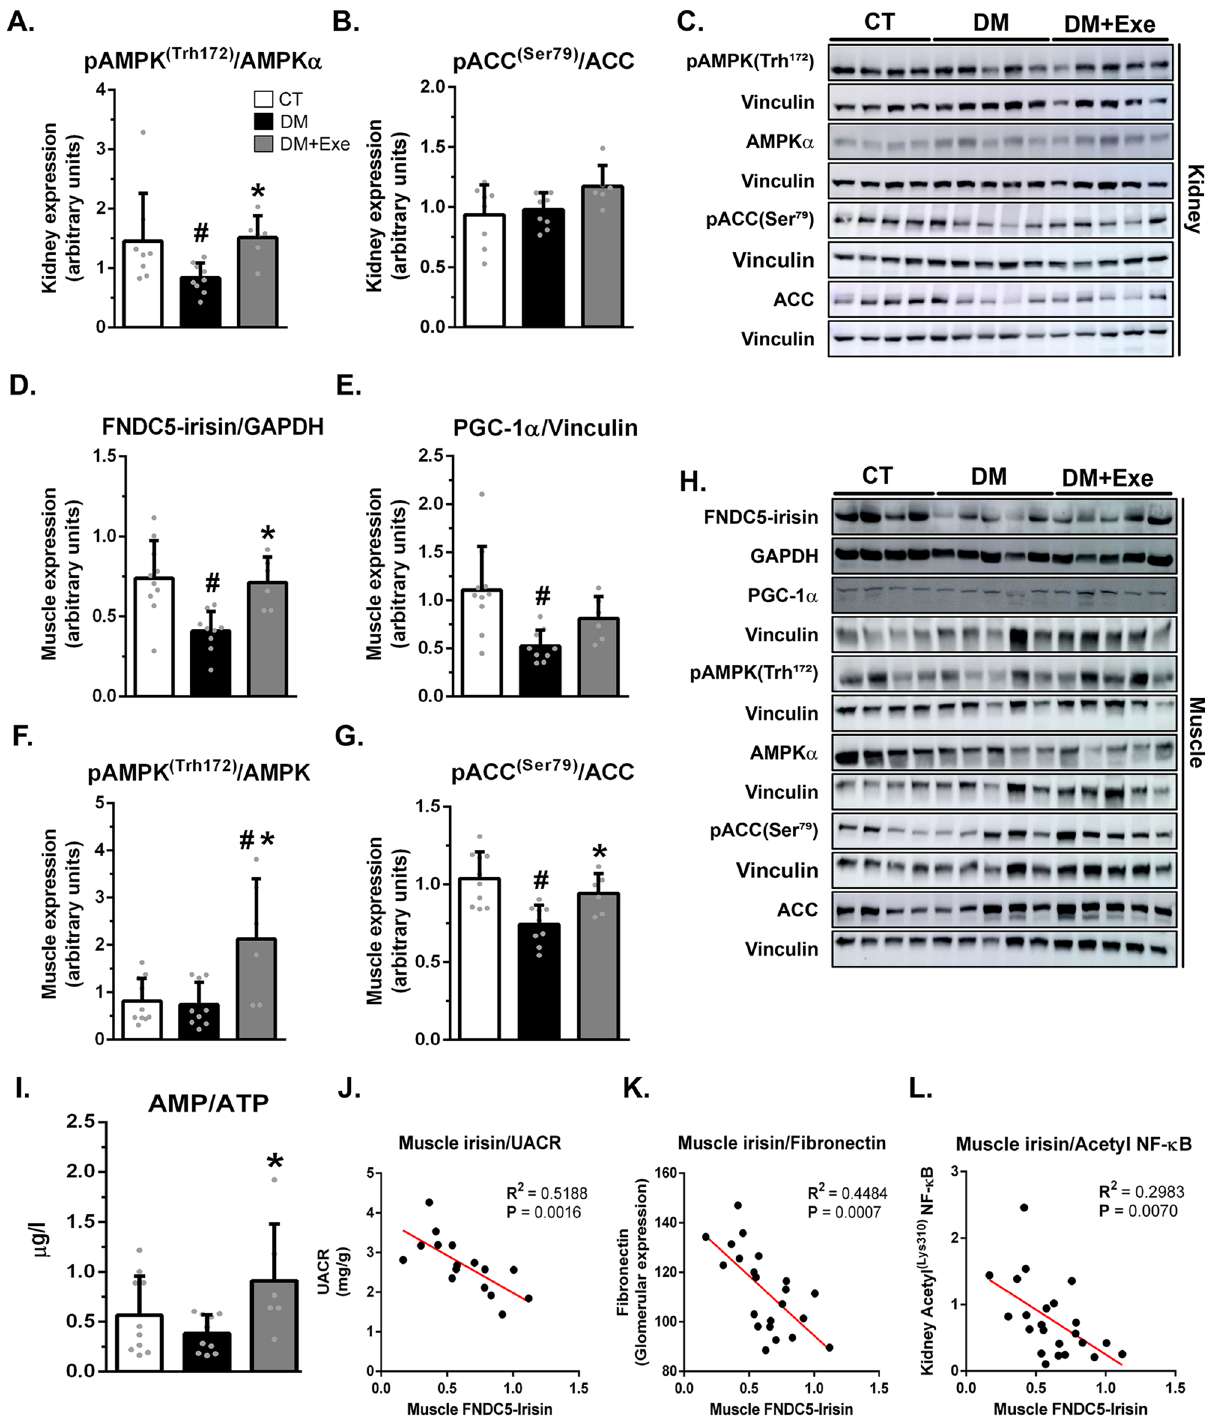
Figure 2. Eight weeks of aerobic physical exercise in diabetic rats was associated with renal and muscle AMPK activation and an elevation in the expression of FNDC5-irisn and PGC1-α in the muscle. ( A – C ) Western blot analysis of pAMPK (Thr172) , AMPKα, pACC (Ser79) , ACC, and vinculin in the renal cortex followed by quantitation of pAMPK (Thr172) /vinculin by AMPKα/vinculin ratio ( A ) and pACC (Ser79) /vinculin by ACC/vinculin ratio ( B ). ( D – H ) Western blot analysis of FNDC5-irisn, GADPH, PGC-1α, vinculin, pAMPK (Thr172) , AMPKα, pACC (Ser79) , and ACC in the muscle ( H ), followed by quantitation of FNDC5-irisn/GADPH ( D ), PGC-1α/vinculin ( E ), pAMPK (Thr172) /vinculin by AMPKα/vinculin ( F ), and pACC (Ser79) /vinculin by ACC/vinculin ratio ( G ). ( I ) Muscle AMP/ATP ratio. ( J – L ) Correlations of muscle irisin vs. UACR ( J ) as well as muscle irisin vs. glomerular fibronectin ( K ) and renal acetyl NF-κB ( L ). Protein expression levels were normalized to vinculin or GAPDH. Blots are representative of three independent experiments. Results are means ± SE. CT, nondiabetic; DM, sedentary diabetic; DM + Exe, exercised diabetic. UACR, urinary albumin-to-creatine ratio. ACC, acetyl-CoA carboxylase. # p < 0.05 vs. CT; * p < 0.05 vs.